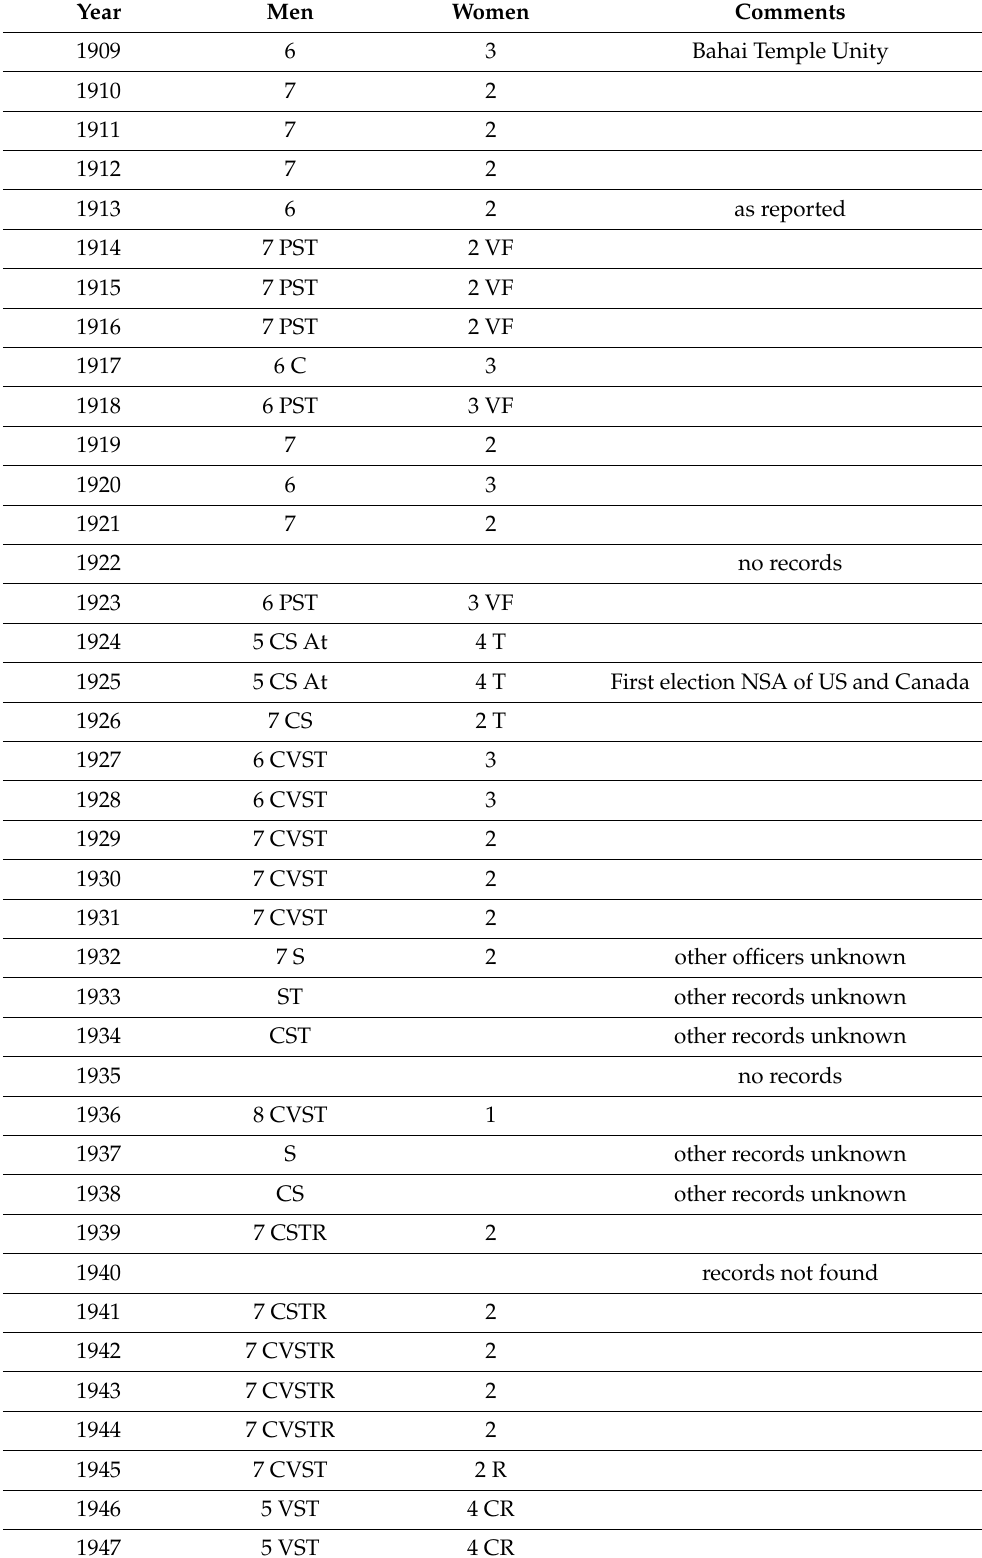
Table 2. Membership of the American National Spiritual Assembly (Statistics of initial election; by-elections not